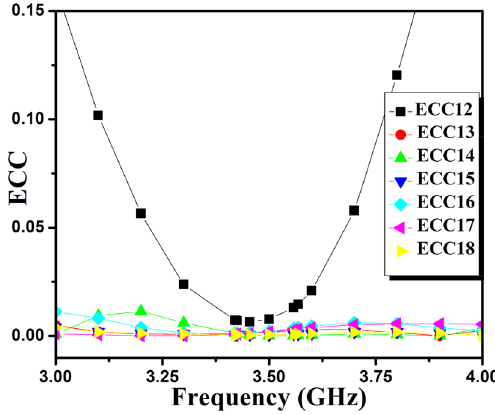
Figure 24. Proposed 8 Members MIMO antenna ECC.